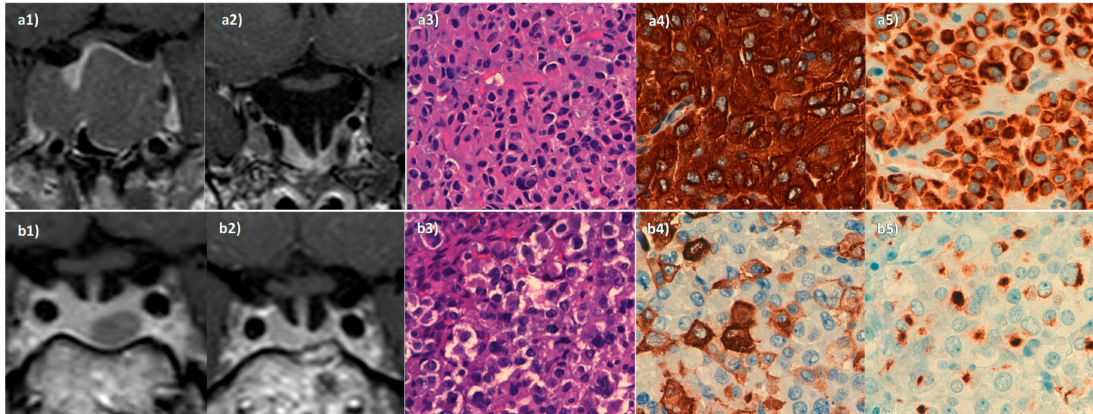
Figure 2. Histological images of pituitary tumours with different tumours consistencies. Case 1. Invasive pituitary adenomas (Knosp grade 4) of very hard consistency in the preoperative ( a1 ) and ( a2 ) small remnant in right cavernous sinus in the postoperative (coronal sections). The specimen was a densely granulated somatotroph tumour. Hematoxylin-eosin ( a3 ) showed an acidophilic tumour, that stained strongly for GH ( a4 ). Cytokeratin CAM5.2 ( a5 ) staining was diffuse with a reinforce perinuclear pattern. Case 2. Knosp grade O pituitary adenomas of soft consistency in the preoperative ( b1 ) and postoperative with complete tumoral resection ( b2 ) (coronal sections). The lesion was a sparsely granulated somatotroph tumour. Hematoxylin-eosin ( b3 ) revealed a chromophobic tumour with focal GH staining ( b4 ). Cytokeratin CAM5.2 ( b5 ) showed a dot-like perinuclear pattern corresponding to fibrous